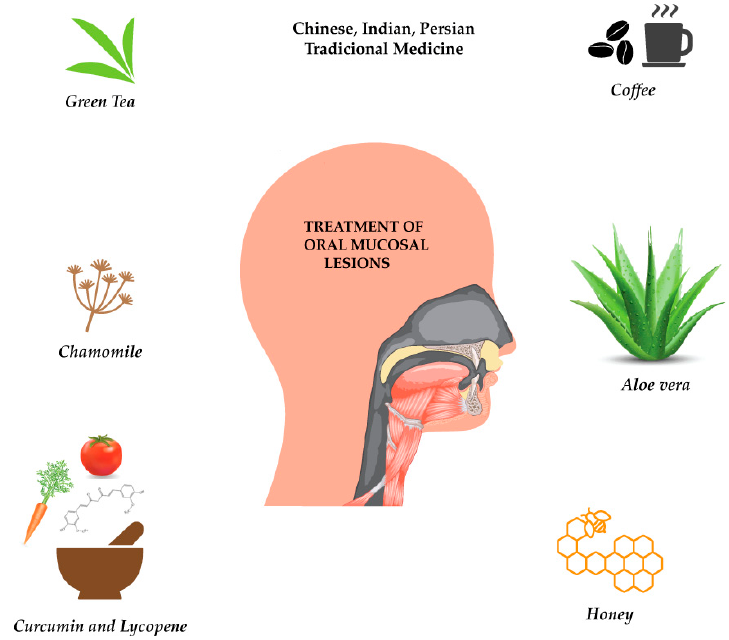
Figure 1. Plants and plant-derived bioactives in oral mucosal lesions.